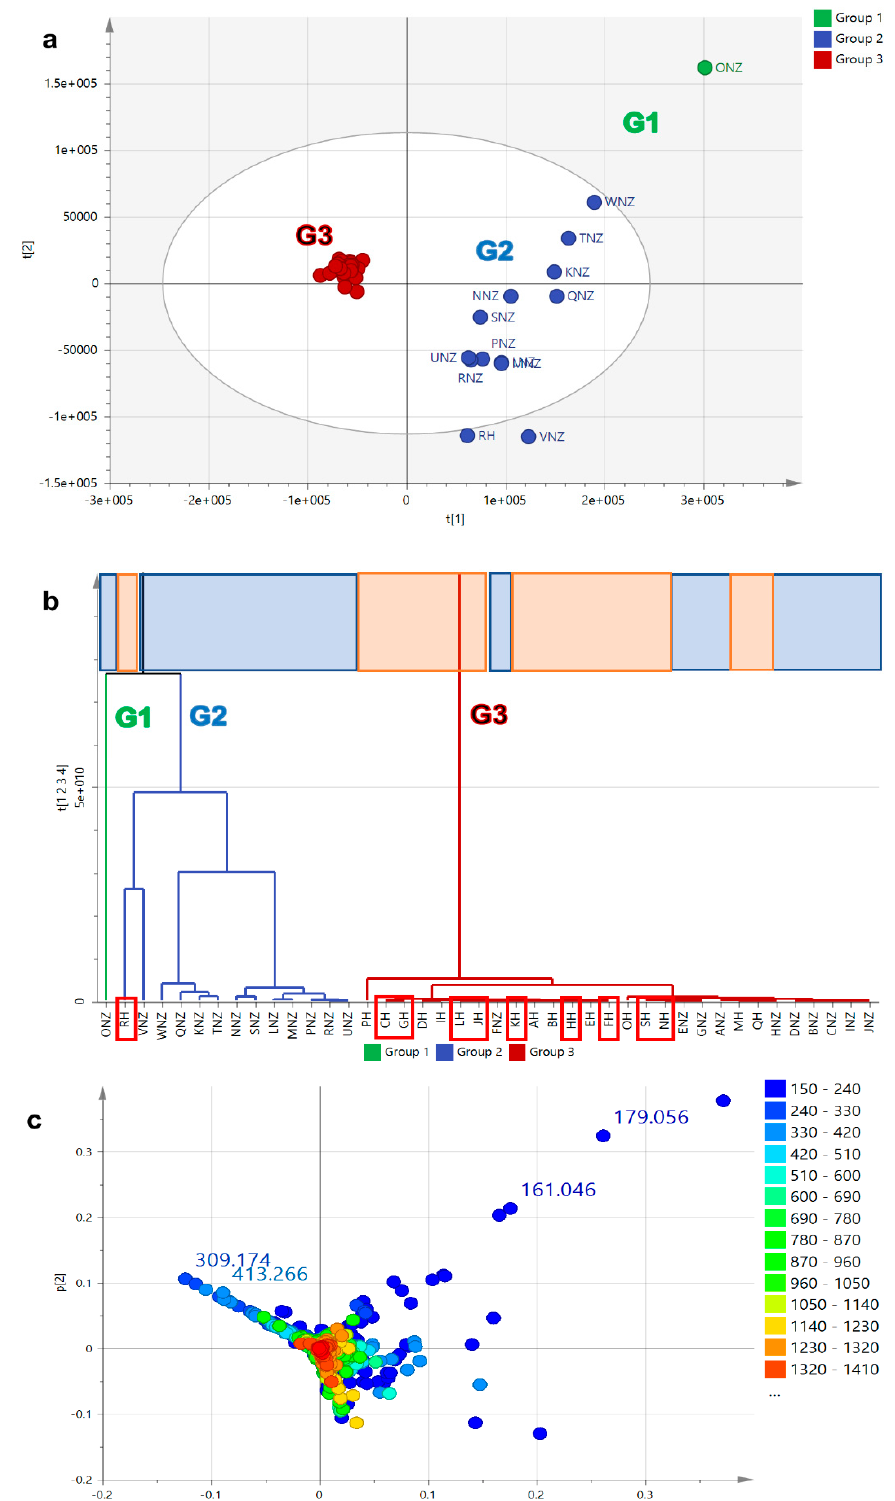
Figure 3. PCA model employing HRMS dataset. ( a ) Scores, ( b ) HCA, and ( c ) loadings plots and of honey extracts based on HR-LCMS (R 2 = 0.60 and Q 2 = 0.46). Bioactive samples were boxed in red. Highlighted upper boxes on HCA dendrogram ( b ) represents origin of honey samples where blue represents the New Zealand (NZ) samples while the Malaysian samples were highlighted in orange.